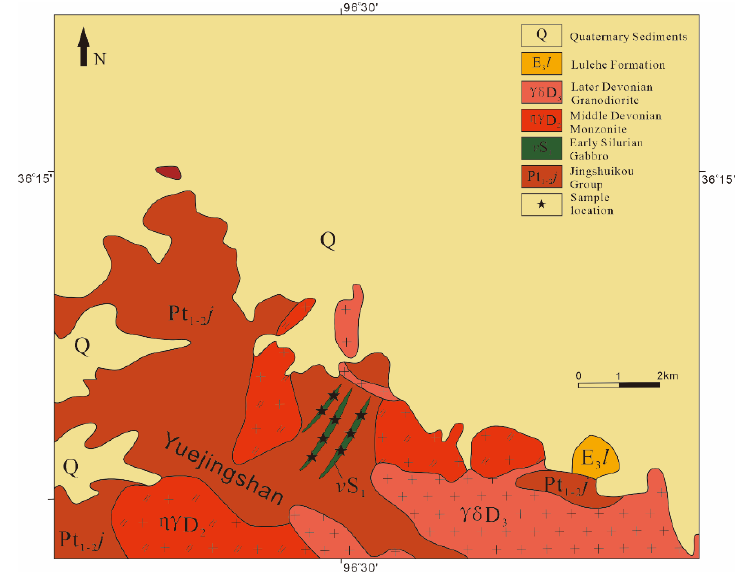
Figure 2. Simplified geological map of the Yuejingshan area.